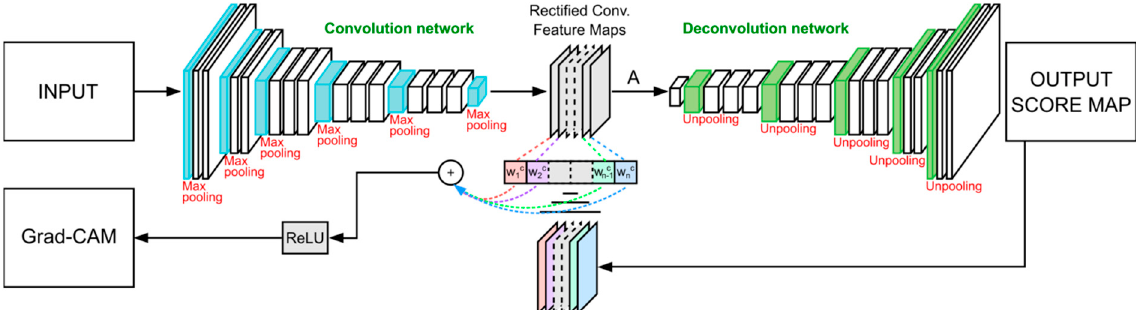
Figure 3. Grad ‐ CAM method for a segmentation network.